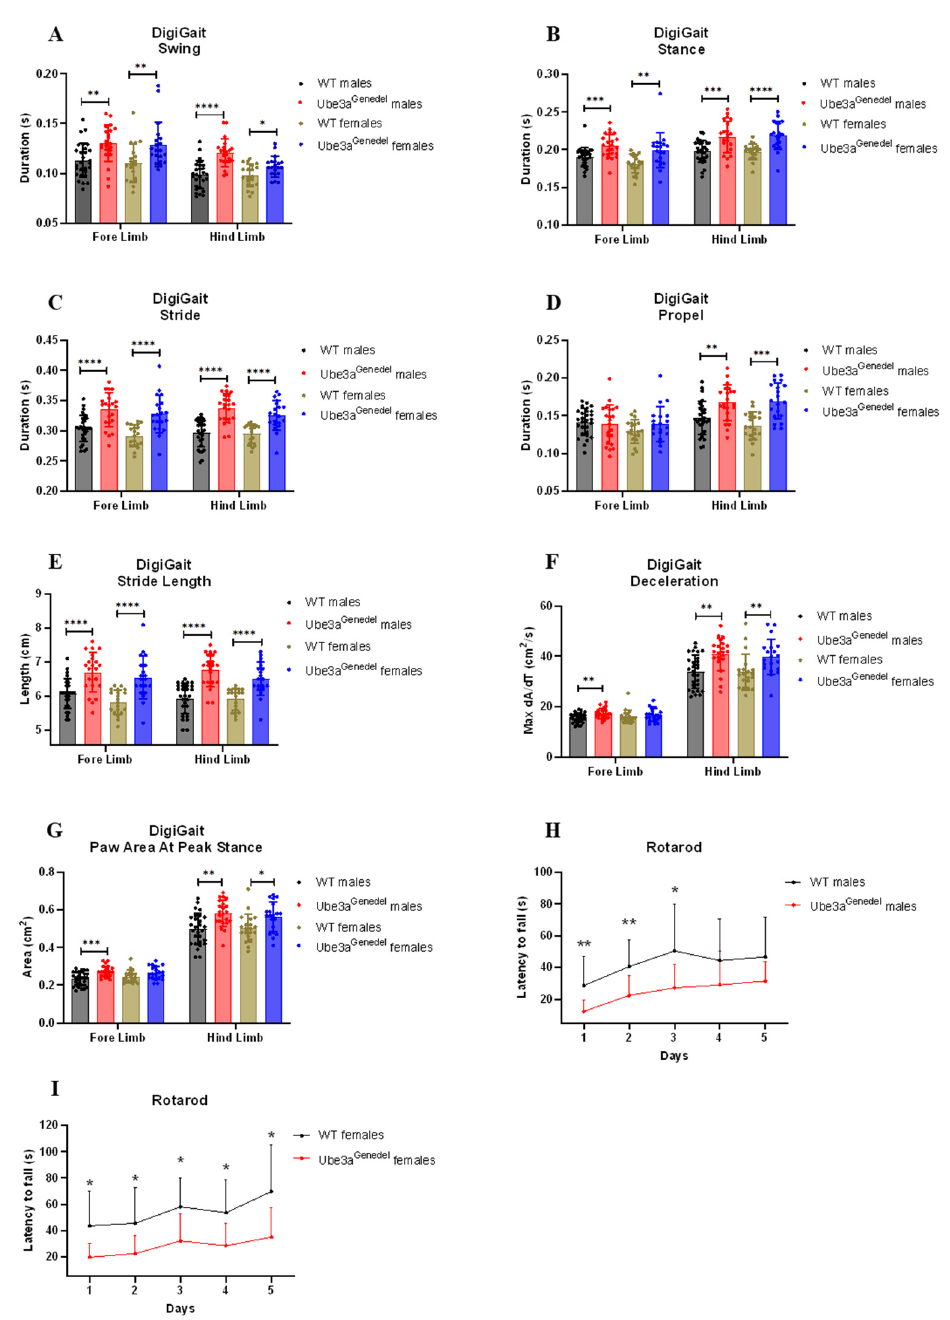
Figure 2. Results of gait analysis and rotarod. ( A – G ) Gait parameters were measured with the DigiGait platform. The data show an increase in the duration of swing, stance, stride, and propel in Ube3a genedel animals. Stride length, MAX dA/dt, and the paw area at peak stance were also increased in Ube3a genedel animals in both sexes; two-way ANOVA: genotype main effect, p < 0. ( H , I ) Ube3a genedel mice had significantly shorter latency to fall; two-way ANOVA with dependent measurements genotype main effect: p < 0. All data represent means ± SD. Significant effects of genotype are indicated as * p < 0.05, ** p < 0.01, *** p < 0.001, and **** p < 0.0001 for genotype